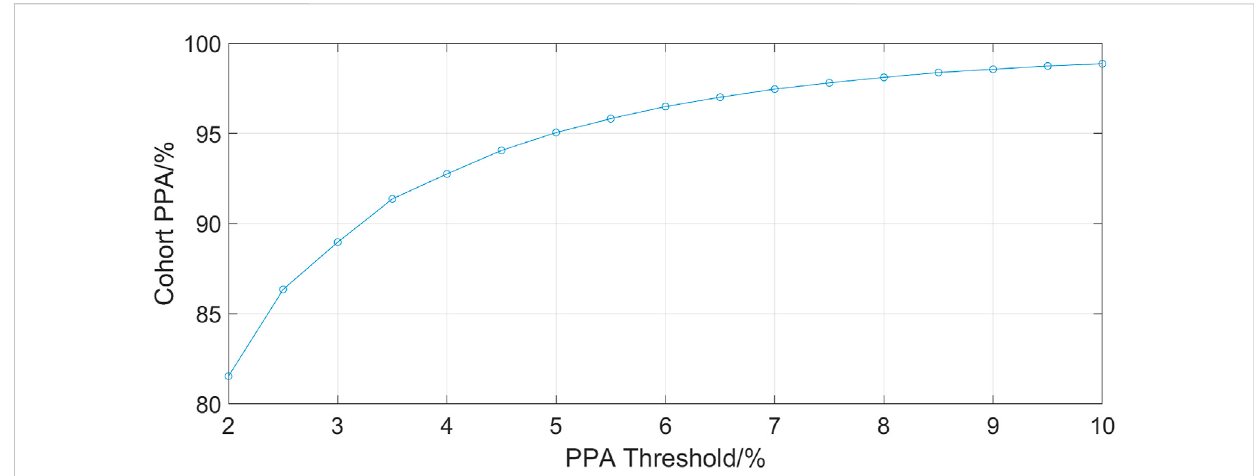
FIGURE 2 AplotofPPAthresholdagainstthecohortPPAvalue.ThePPAthresholdwasde fi nedasthefhPPGheartratebeingwithinacertainpercentageofthe PO heart